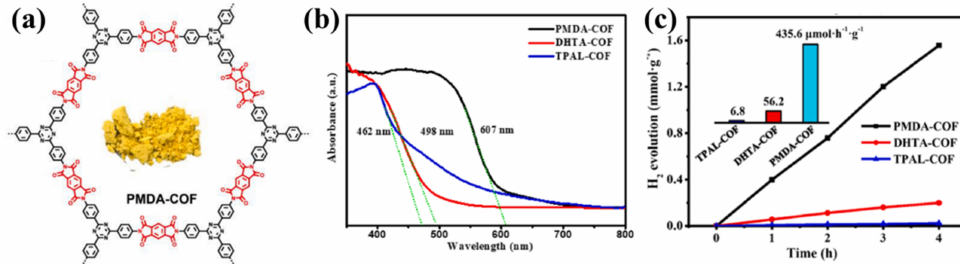
Figure 11. ( a ) Schematic illustration of the chemical structure of PMDA-COF. ( b ) UV–Vis diffuse reflectance spectra and ( c ) H 2 evolution rates of the three COFs. Reproduced with permission from Ref. [53]. Copyright: Elsevier,